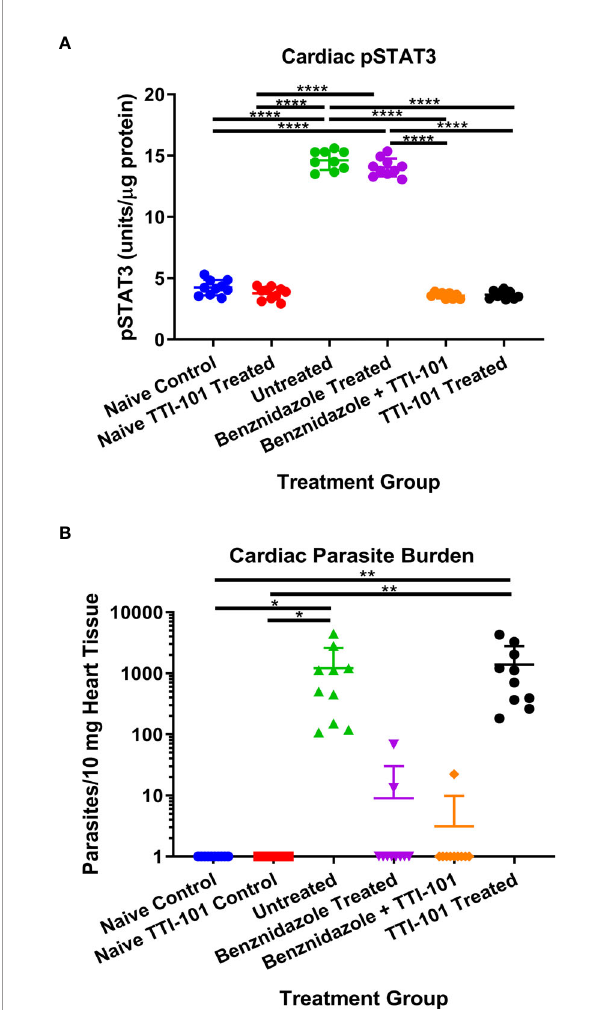
FIGURE 3 | Cardiac parasite burden and signal transducer and activator of transcription-3 (STAT3) activity. Shown are the mean ± SD concentrations of pY-STAT3 measured in cardiac tissue (A) and the relative parasite burden per 10 mg cardiac tissue measured with qPCR at 91 days post infection (B) . Data were analyzed with Student ’ s t-test; *p < 0.05, **p < 0.01, ****p <